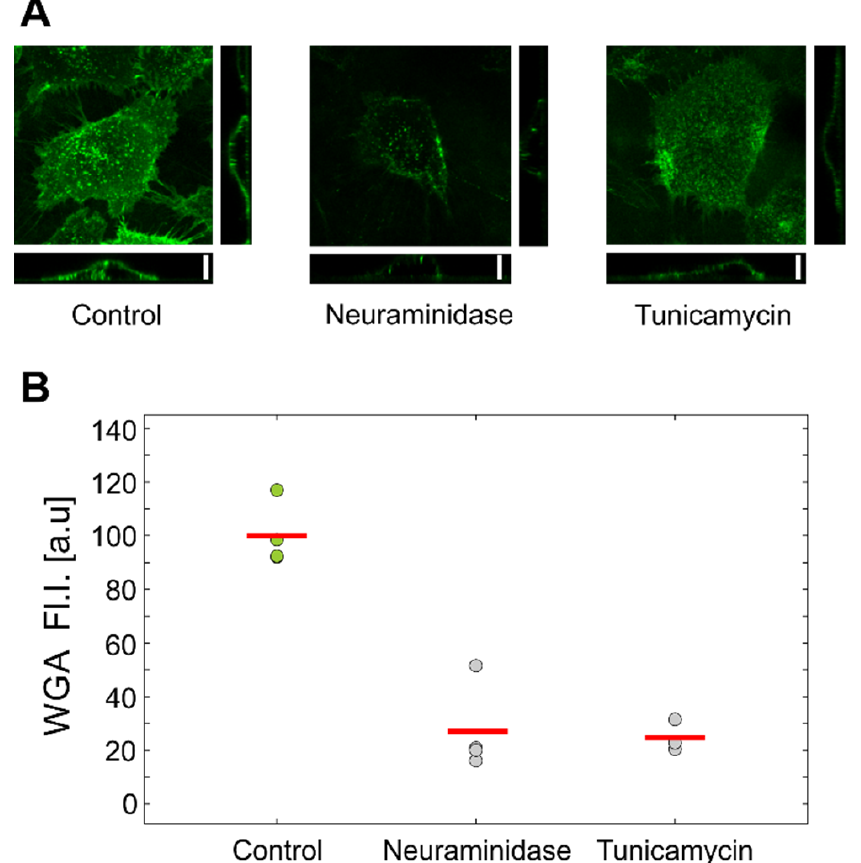
Figure 4. Assessment of glycocalyx in treated HUVEC cells. ( A ) Maximum intensity projection and side-projections of representative confocal images of control and treated cells. ( B ) Fluorescence intensity of WGA-stained cells obtained with flow cytometry.